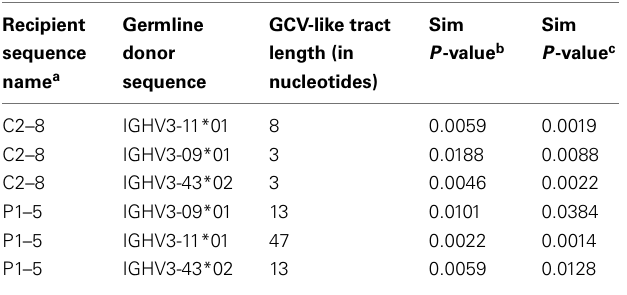
Table 4 | Characteristics of base substitutions in GCV-like tracts shown in Figure